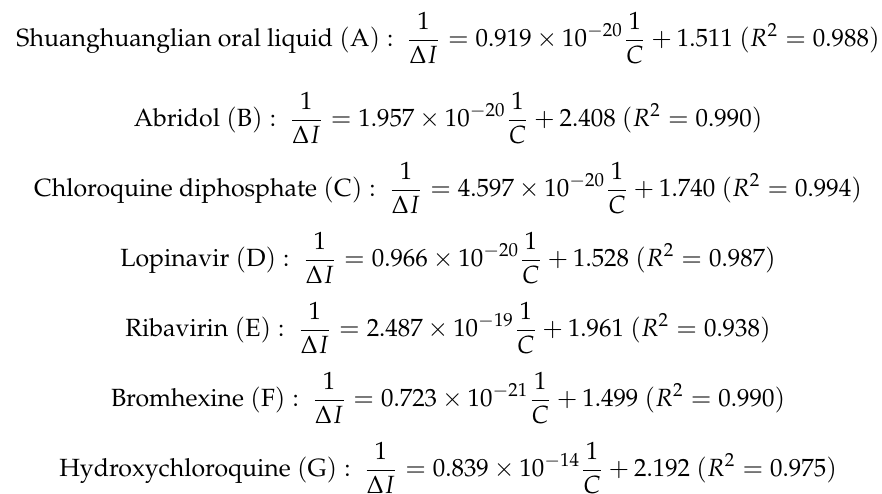
Dist From rmsd l.b.